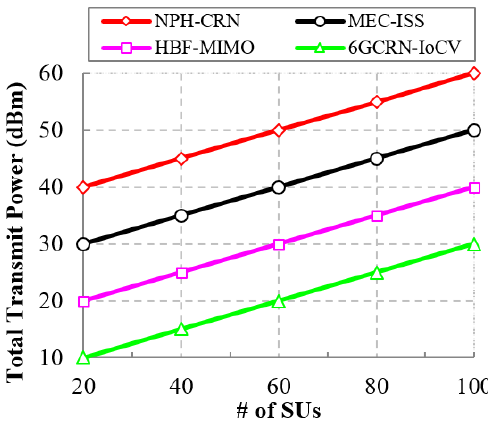
Figure 17. Total transmit power vs. the number of SUs.